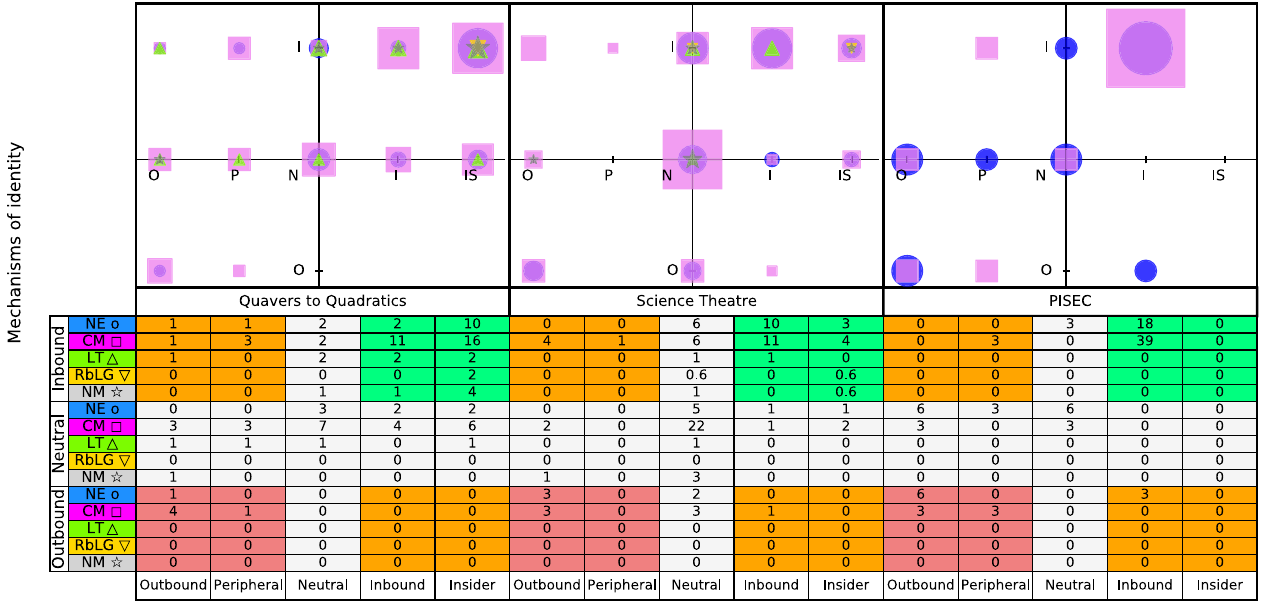
FIG. 6. The mechanisms of identity overlap with the negotiability of the repertoire. The frequency of the overlapping is represented by the size of the markers. The table mirrors the plot and shows the frequencies in each quadrant marked with different